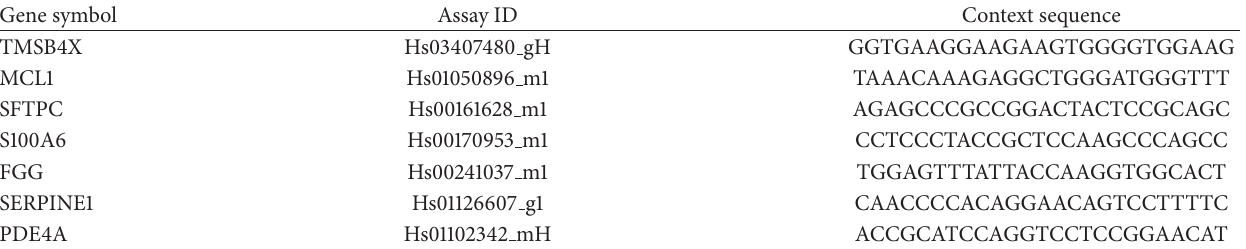
Table 2: Primers for mRNA expression profiling.